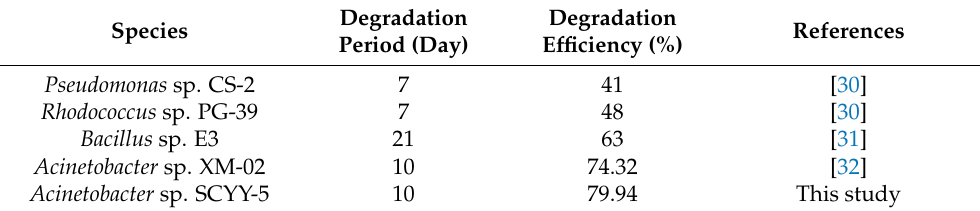
Table 5. Comparison of degradation period and degradation efficiency of hydrocarbons by differ- ent strains. Degradation Degradation Species Period (Day) Efficiency (%) Pseudomonas sp. CS-2